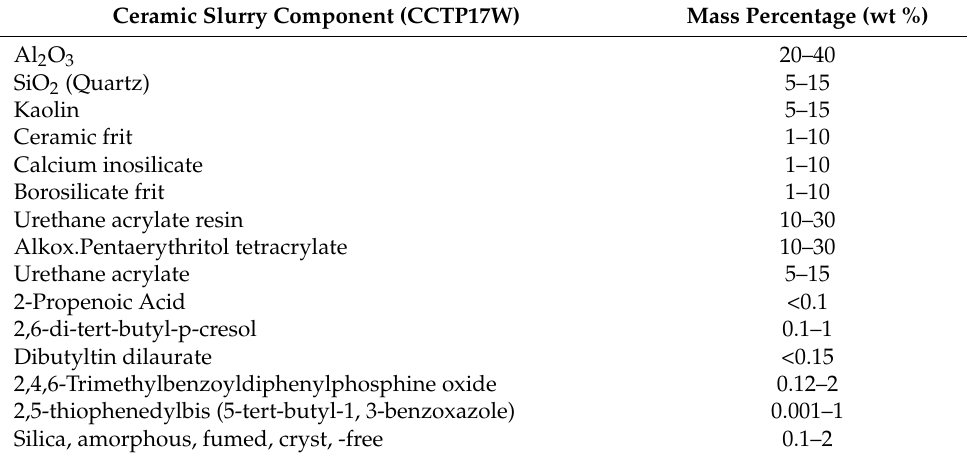
Table 1. Ceramic slurry component ratio.